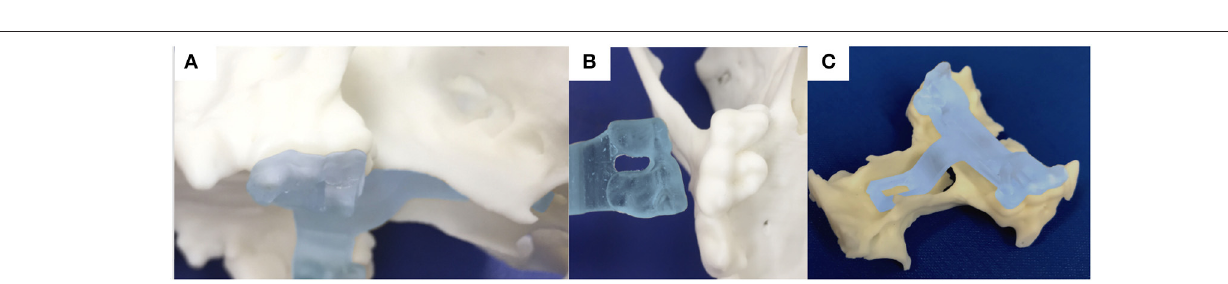
FIGURE 6 | photograph of the 3-dimensional printed skull showing the surface of the molar teeth on the left side in sagittal (A) and ventral (B) views; (C) the printed guide can lock on the molar teeth and contains an arm extending toward the basisphenoid bone with a shape following the anatomical contour of the hard palate, while avoiding the vomer bone and eventually reaching the outer cortex of the basisphenoid